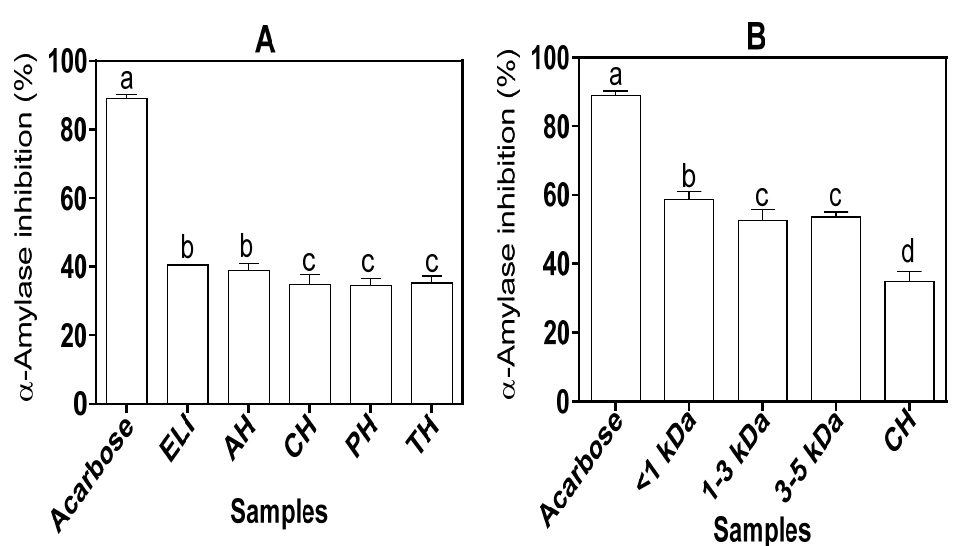
Figure 5. α -Amylase inhibitory activities of ( A ) acarbose (standard), eggplant leaf protein isolate (ELI) and protein hydrolysates alcalase (AH), chymotrypsin (CH), pepsin (PH),and trypsin (TH), and( B ) acarbose (standard) and CH-ultrafiltration peptide fractions. Values are mean ± standard deviation of three determinations. Bars with different letters (a–d) on the same layout are significantly different ( p ≤ 0.05).